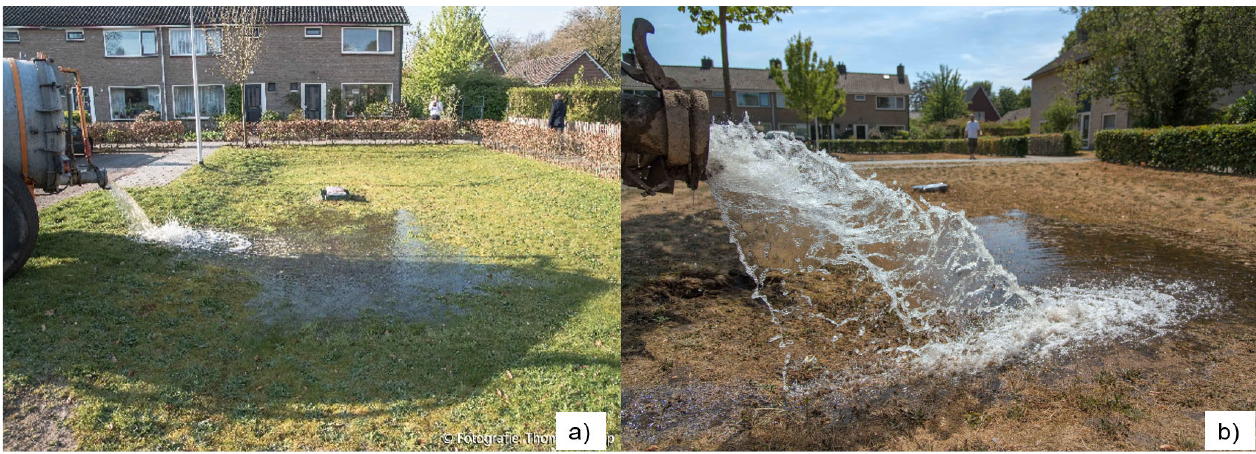
Figure 6. The full-scale infiltration test with a tank truck executed repetitively for monitoring the hydraulic behaviour of swales in Dalfsen—( a ) under regular conditions in 2017, ( b ) Same monitoring after 7 weeks of drought in 2018.